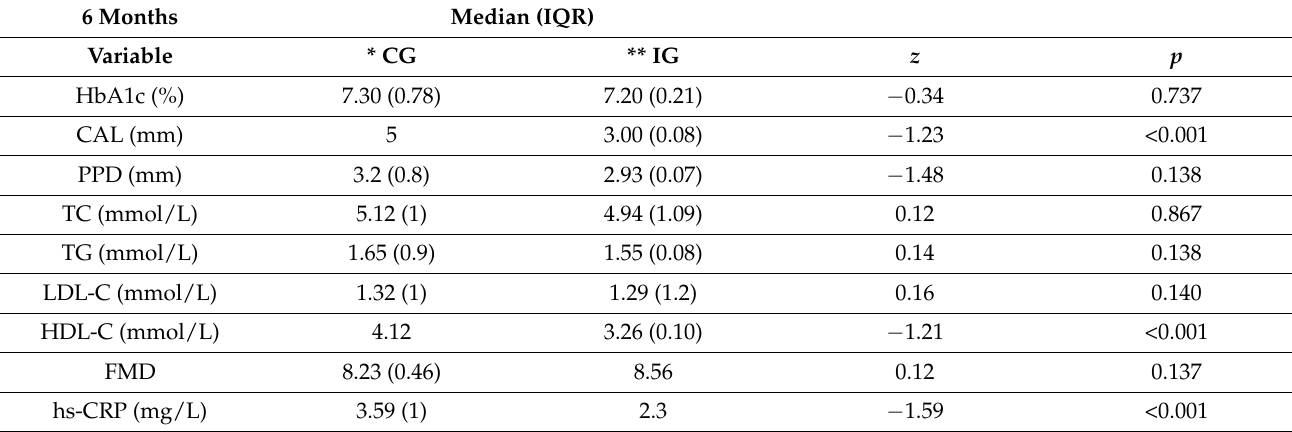
Table 3. Two-tailed Wilcoxon signed rank test at 6 months.